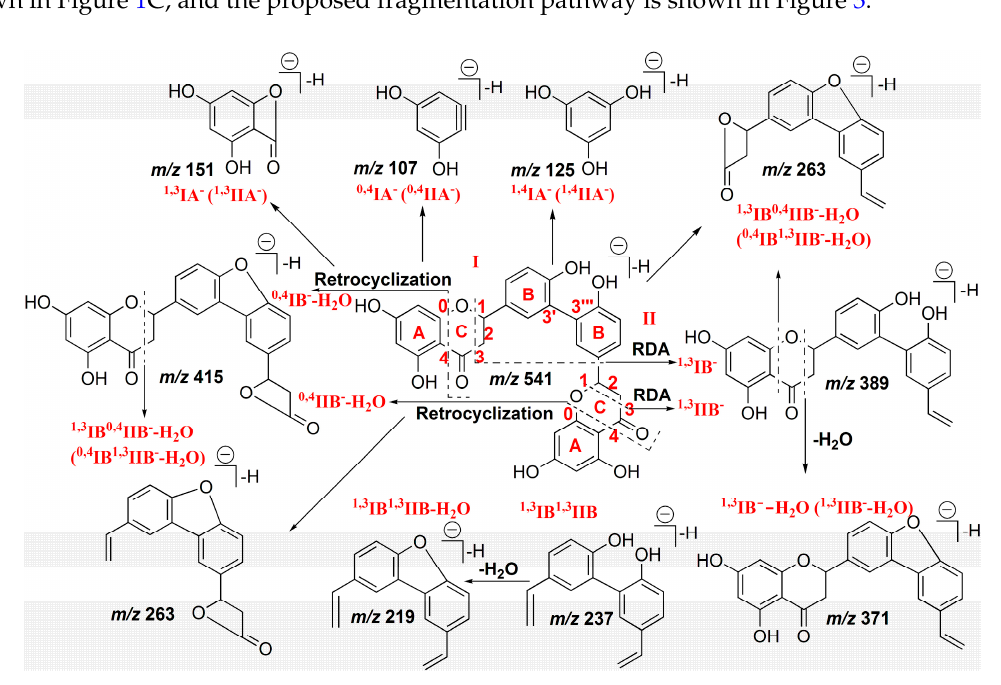
Figure 3. Proposed fragmentation pathway of 3 ′ ,3 ′′′ -binaringenin in ( − )ESI mode.